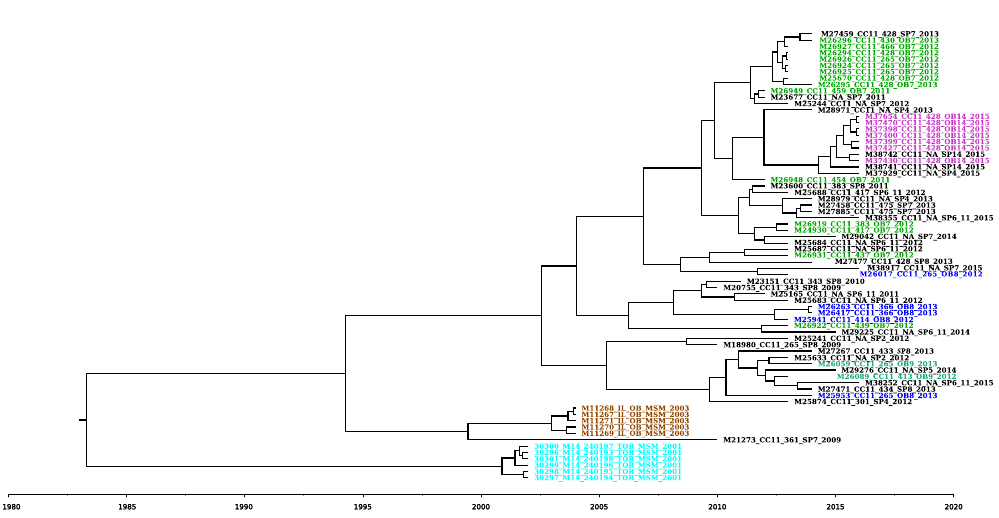
Figure 4. Timed phylogenetic tree of NmC CC11 outbreak and sporadic isolates. A time-dependent phylogenetic reconstruction of the NmC CC11 outbreak and sporadic isolates, inferred by Bayesian inference using BEAST. The NmB CC11 consisted of 71 isolates from 6 outbreaks (OB7, OB8, OB9, OB14, Chicago (2003), and Toronto (2001)), along with the geographically matched sporadic isolates (SP7, SP8, SP9, and SP14). M26263 and M26417 were isolates from the same person. Each colored branch and isolate label represents a different outbreak.